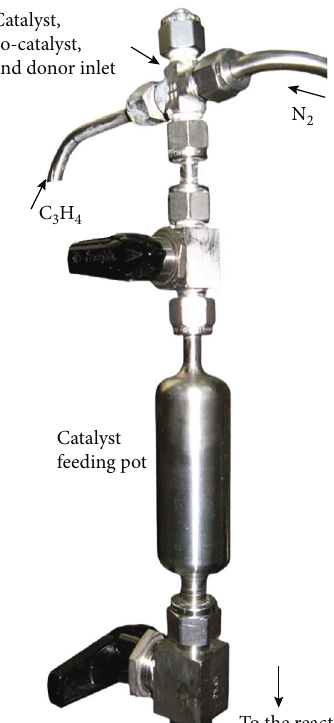
Figure 1: Catalyst, cocatalyst, and external donor feeding system.